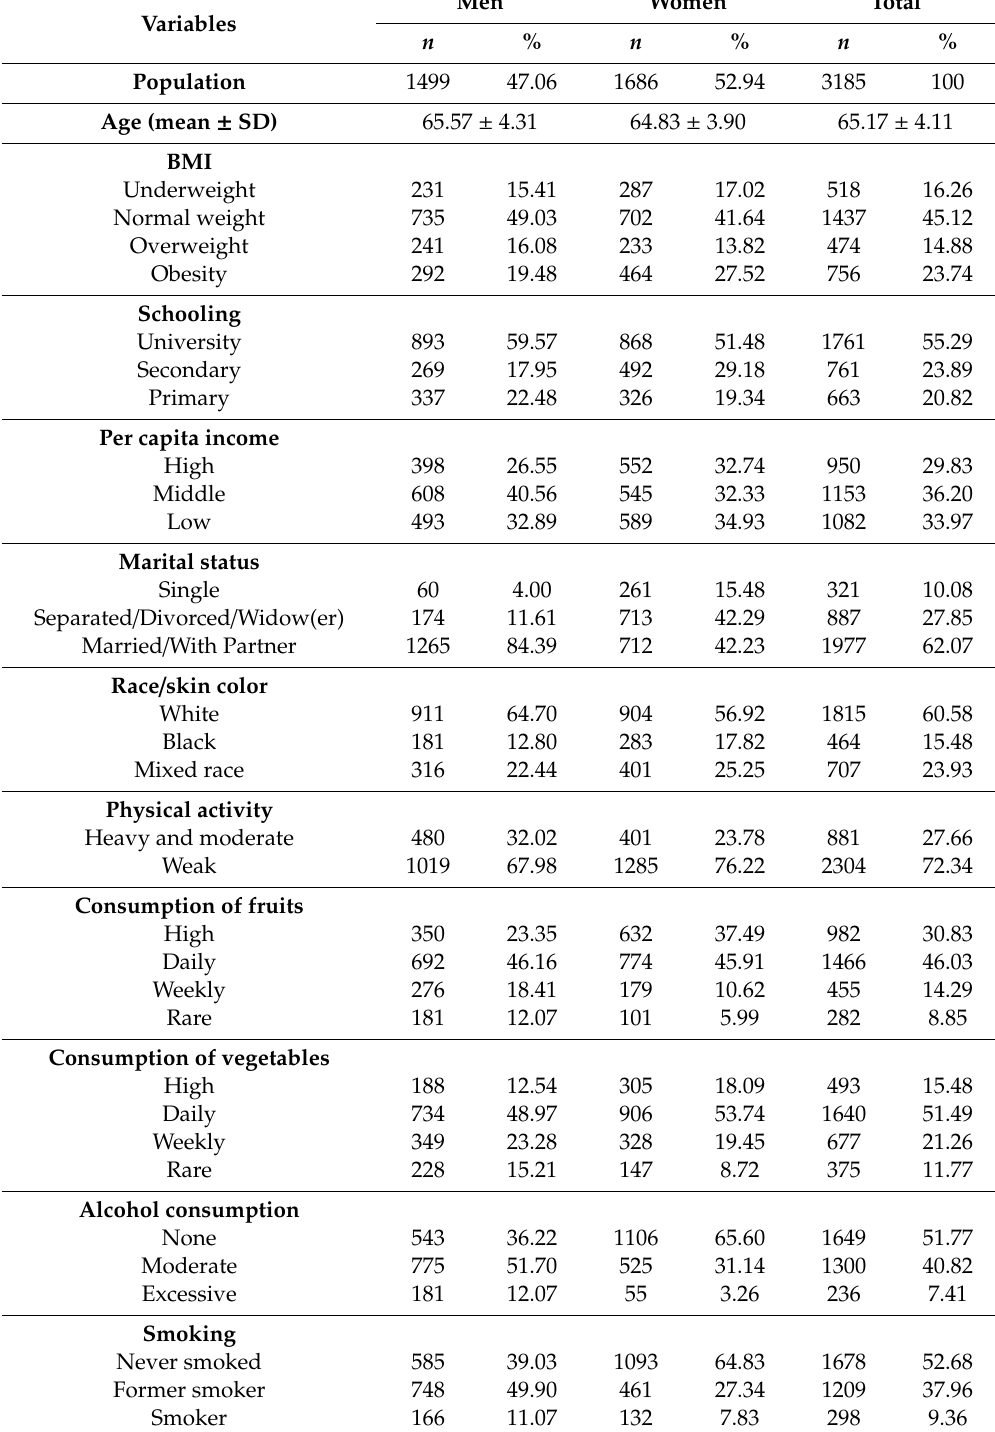
Table 2. Sociodemographic, anthropometric, and behavioral characteristics of elderly participants in the Brazilian Longitudinal Study of Adult Health (ELSA-Brasil) study